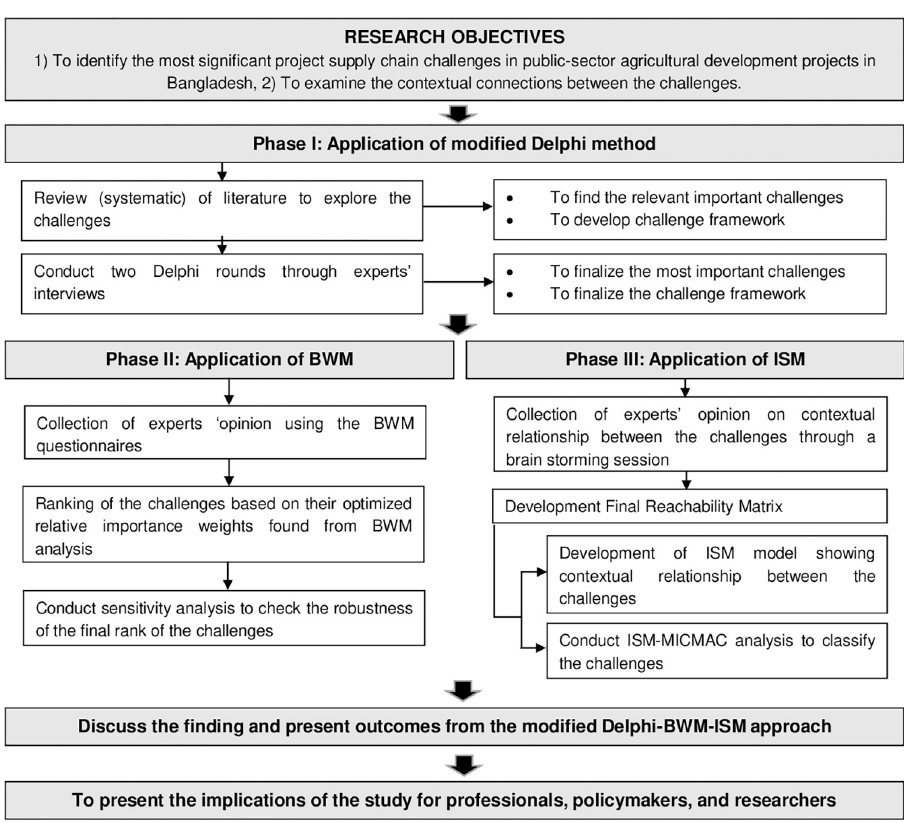
Fig 3. Research methodology. Note: BWM- Best Worst Method, ISM- Interpretive Structural Modeling, MICMAC- cross-impact matrix multiplication applied to